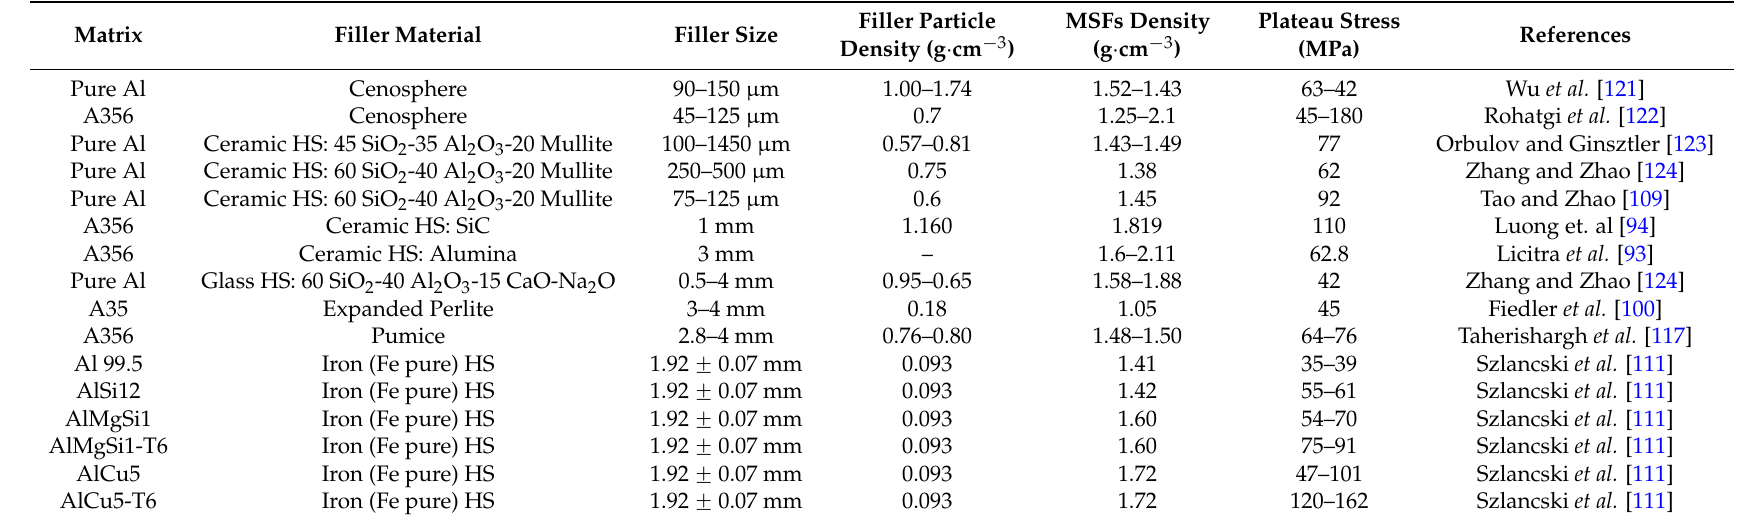
Table 7. Literature data on other aluminum alloy syntactic foams with different